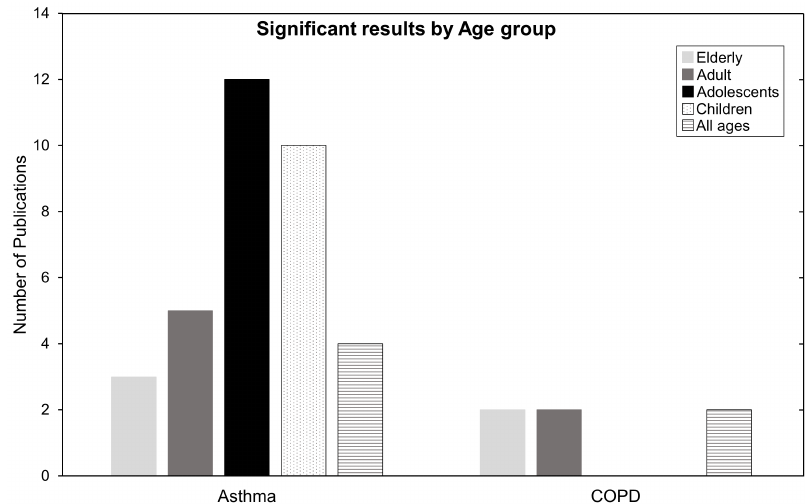
Figure 7. Number of publications categorized by age for Asthma and COPD. Children ages 0–12, adolescents ages 13–18, adults ages 19–64, and elderly ages 65+. Some publications have one or more age group and are therefore counted twice or